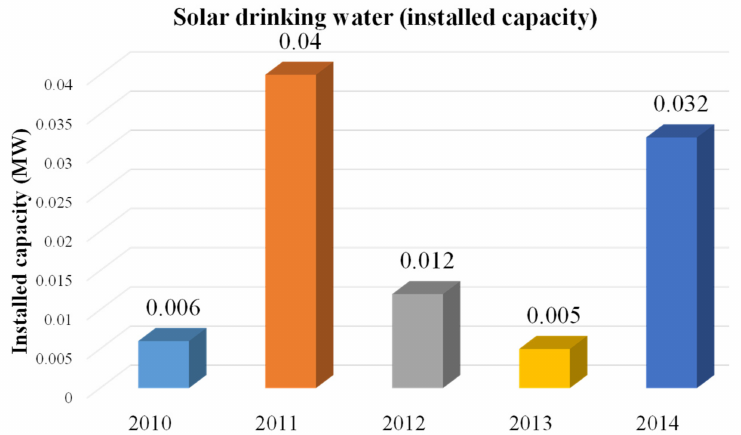
Figure 22. The historical installed capacity of solar drinking water (2010–2014) (authors’ creation based on SREDA data